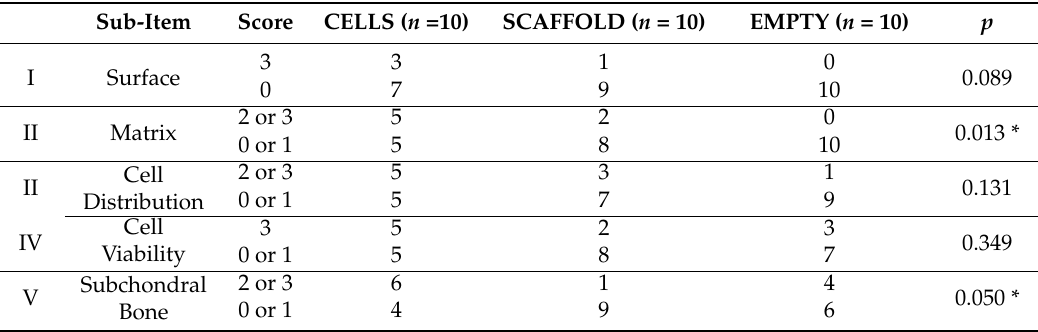
Table 1. Absolute frequencies of the ICRS 1 microscopic scale sub-items. Sub-item VI (Calcified Cartilage) was not used because the partial thickness model preserved this layer.